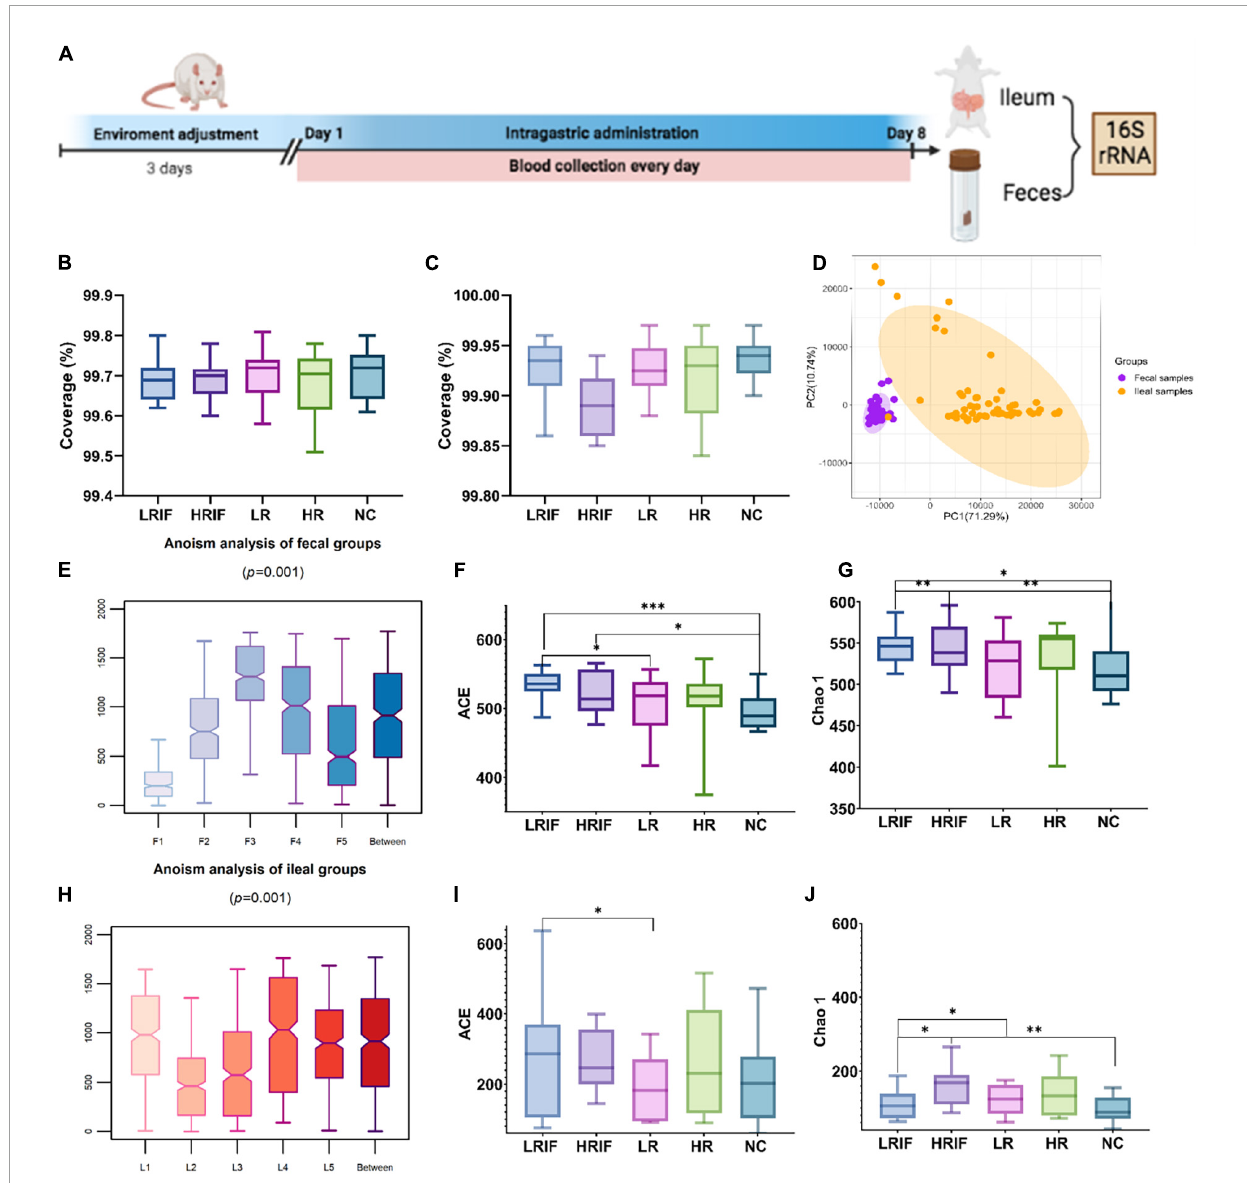
FIGURE2 Phylogenetic diversity of gut microbiomes among LRIF, HRIF, LR, HR, and NC groups in fecal and ileal samples. (A) Graph explained the protocol of animal experiment. (B) Microbiota coverage of LRIF, HRIF, LR, HR, and NC groups in feces samples. (C) Microbiota coverage of LRIF, HRIF, LR, HR, and NC groups in ileum samples. (D) Principal component analysis (PCA) based on operational taxonomic unit (OTU) level microbiota composition of all feces and ileum samples (PC1 = 71.29%, PC2 = 10.74%). Feces samples are indicated by purple dots and ileum samples by orange dots. The colors denote individual samples. (E) Anosim analysis of gut microbiota based on unweighted UniFrac distance of feces samples. (F) ACE index of the microbiota from LRIF, HRIF, LR, HR, and NC groups in feces samples. (G) Chao1 index of the microbiota from LRIF, HRIF, LR, HR, and NC groups in feces samples. (H) Anosim analysis of gut microbiota based on unweighted UniFrac distance of ileum samples. (I) ACE index of the microbiota from LRIF, HRIF, LR, HR, and NC groups in ileum samples. (J) Chao1 index of the microbiota from LRIF, HRIF, LR, HR, and NC groups in ileum samples. For ACE and Chao1, the horizontal bars within boxes represent median. The tops and bottoms of boxes represent the 75th and 25th percentiles, respectively; N = 12. ∗ P < 0.05, ∗∗ P < 0.01, ∗∗∗ P <